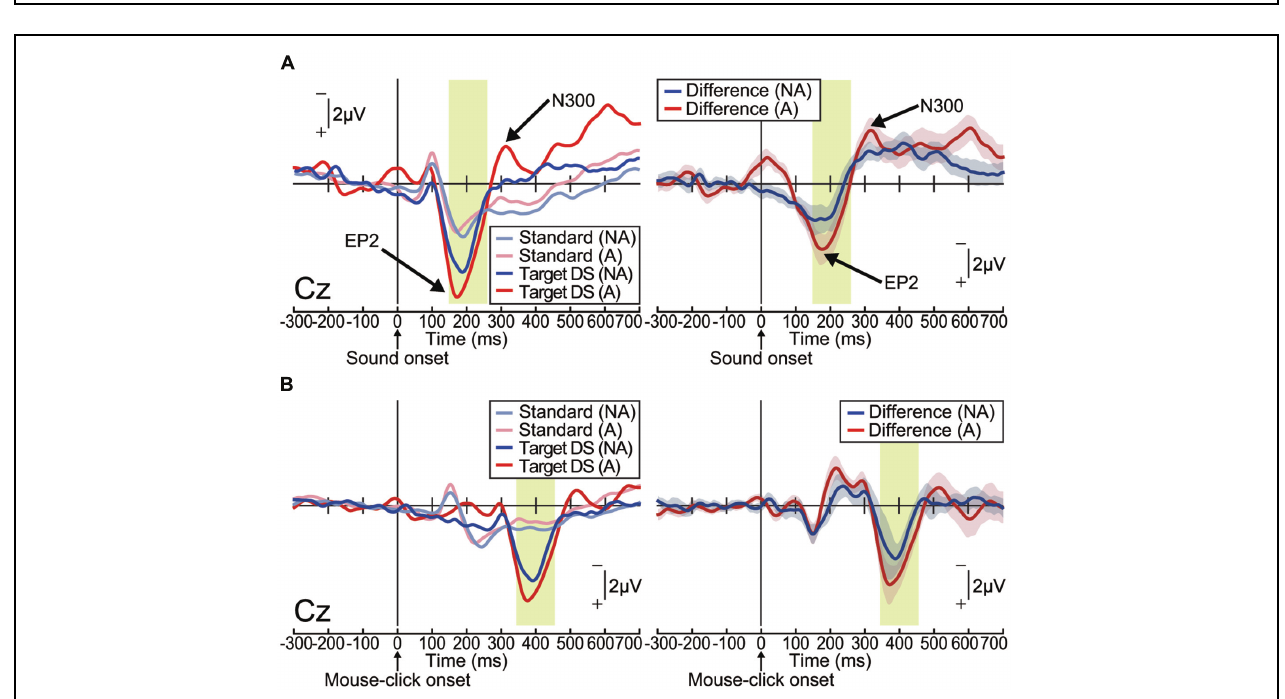
FIGURE 3 | Delayed auditory feedback elicited an enhanced-P2 (EP2) and N300 (Experiment 2). Grand-averaged ERP waveforms computed by (A) auditory stimulus onset or (B) action (mouse-click performed by participant) onset. (A) Left: ERPs elicited by passive presentation of a delayed (150 ms) auditory stimulus (non-action condition; NA) or elicited by the mouse-click action performed by the participant (action condition; A; n = 16). Right: differential (target – standard) ERP waveforms. Shaded (blue or red) areas represent SEM. The EP2 (positive peak around 200 ms) was apparent in both conditions [non-action: t ( 15 ) = 4.89, p < 0.001, effect size r = 0.79; action: t ( 15 ) = 5.99, p < 0.001, effect size r = 0.84]. The N300 (negative peak around 300 ms) followed the EP2 [non-action: t ( 15 ) = 4.30, p < 0.001, effect size r = 0.74; action: t ( 15 ) = 4.71, p < 0.001, effect size r = 0.77]. (B) Left: ERPs elicited by passive presentation (NA) of a delayed (150 ms) auditory stimulus or by a mouse-click performed by the participant (A; n = 16). Right: differential (target – standard) ERP waveforms. Shaded (blue or red) areas represent